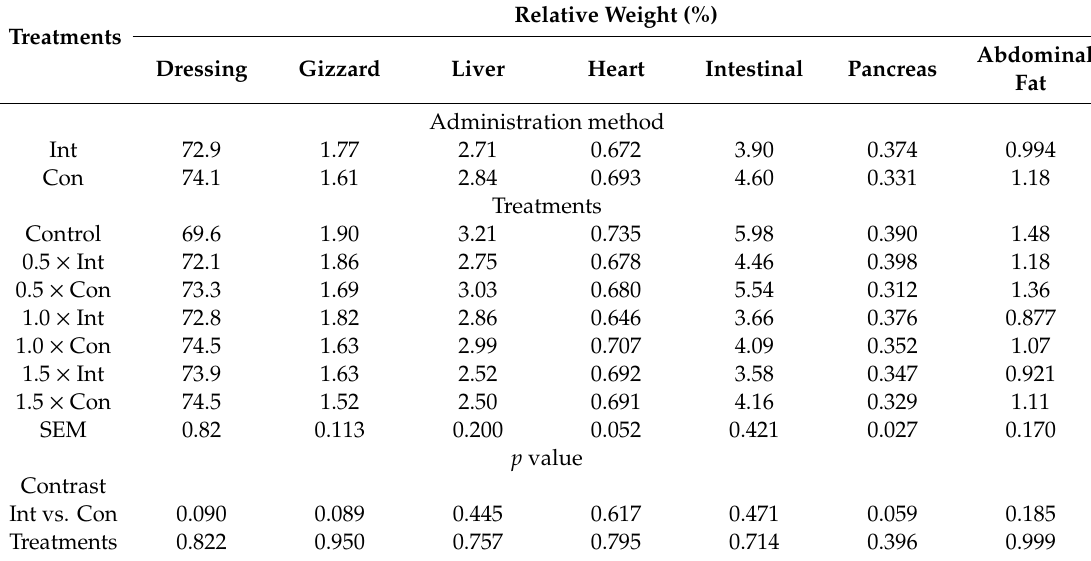
Table 5. E ff ects of multienzymes supplemented continuously or intermittently on carcass and organs characteristics of Arbor Acres broiler chicks during 1–35 days of